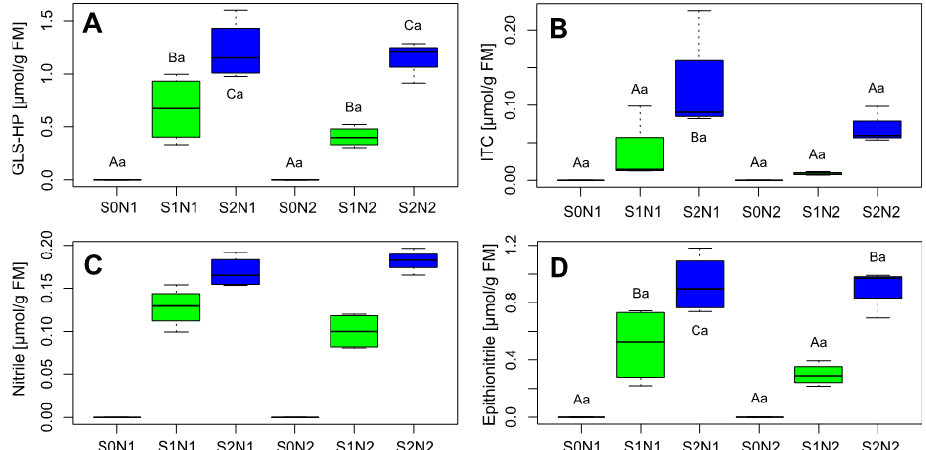
Fig. 5: Total concentration of glucosinolate hydrolysis products (A) as well as isothiocyanates (B), nitriles (C), and epithionitriles (D) in pak choi fertilized with a varied N and S supply. Lower- and uppercase letters indicate significantdifference (p<0.05) between means owing to the effect of N and S supply respectively, S0 = 0 g S, S1 = 0.06 g S, S2 = 0.3 g S, N1 = 0.75 g N, N2 = 1.5 g N.